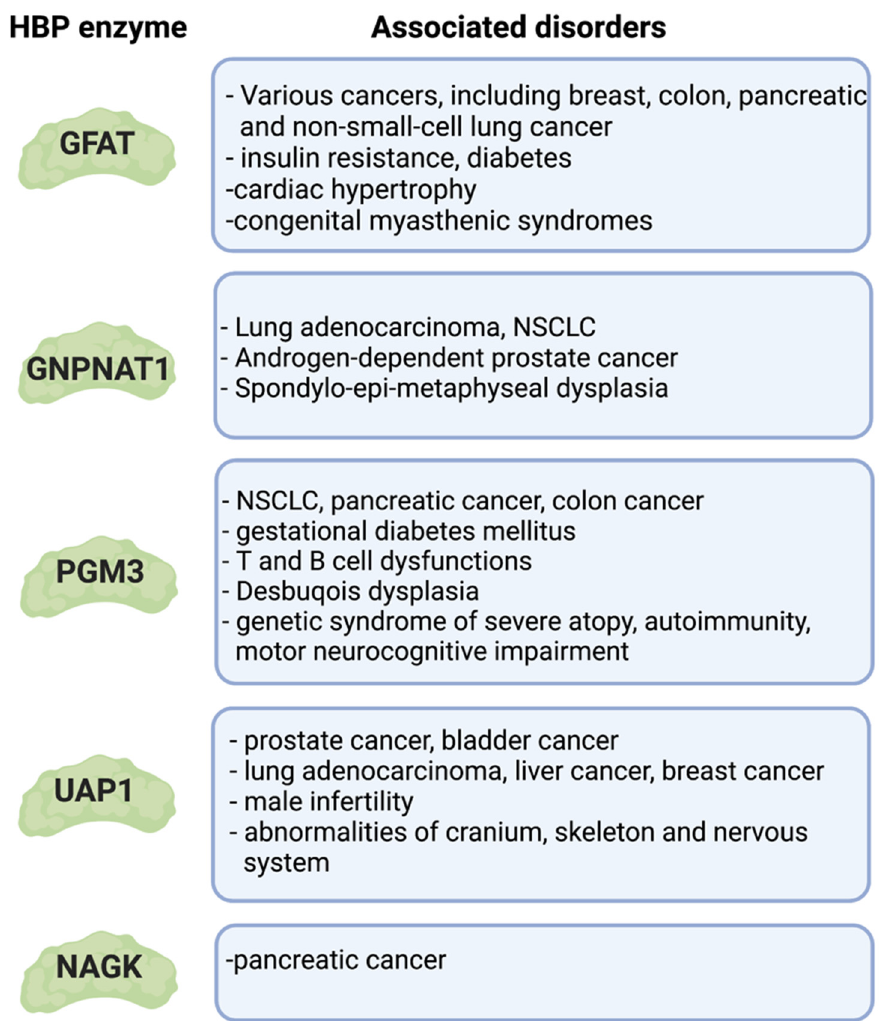
Figure 6. Alterations in the expression and/or regulation of the HBP enzymes have been linked to a variety of diseases.